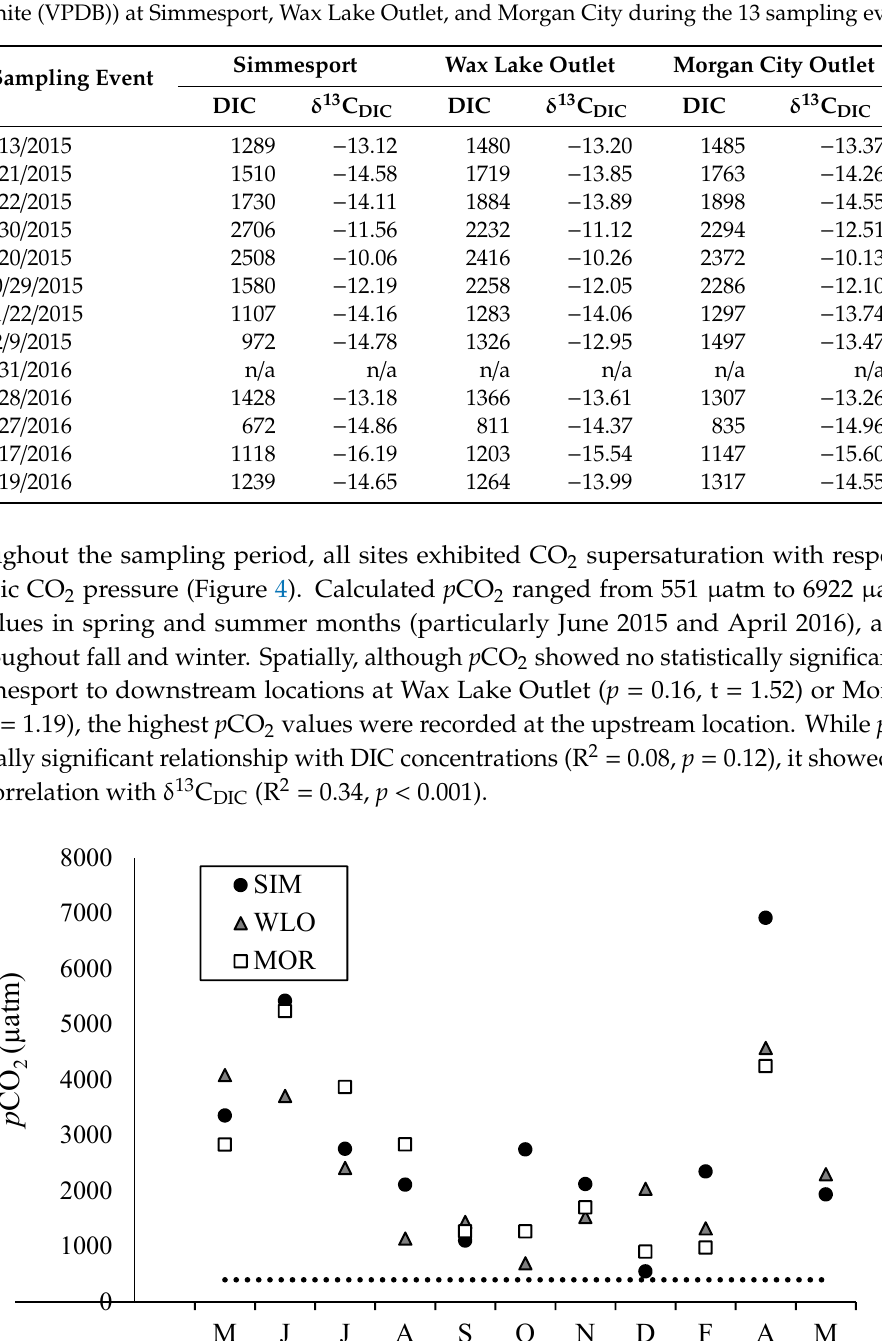
Table 1. Dissolved inorganic carbon (DIC) concentrations ( µ mol L − 1 ) and δ 13 C DIC (% (cid:24) Vienna Pee Dee